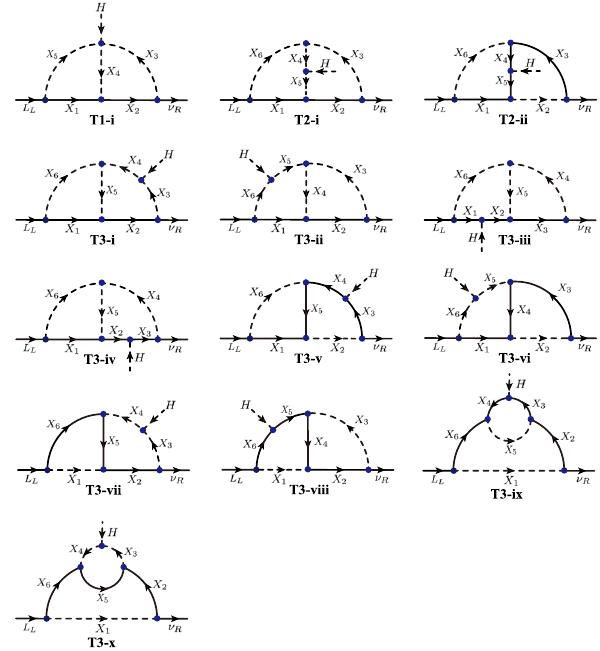
Fig. 3 Genuine two-loop diagrams (the top three) and the ones con- taining a compressible fermion–fermion–scalar vertex [89]. Here the dashed line represents either a scalar or a vector field, while the solid line always denotes a fermion field